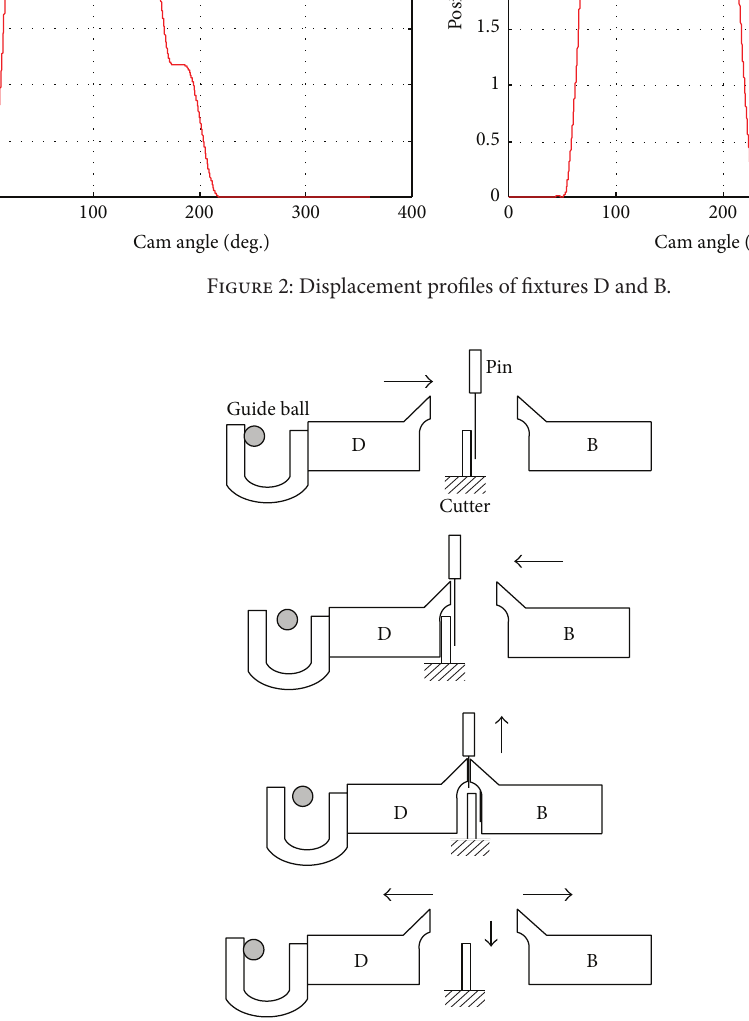
Figure 3: Handling process of the cam-driven fixture